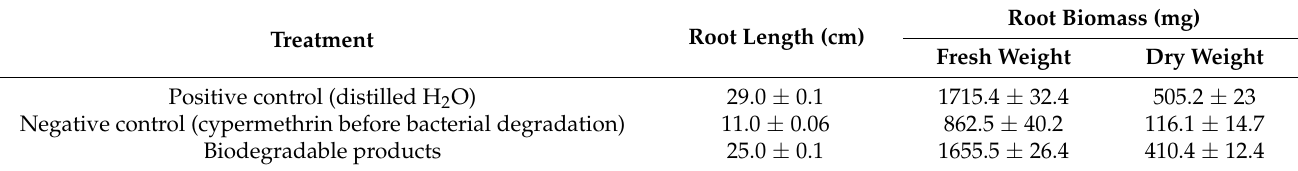
Root Biomass (mg) Fresh Weight